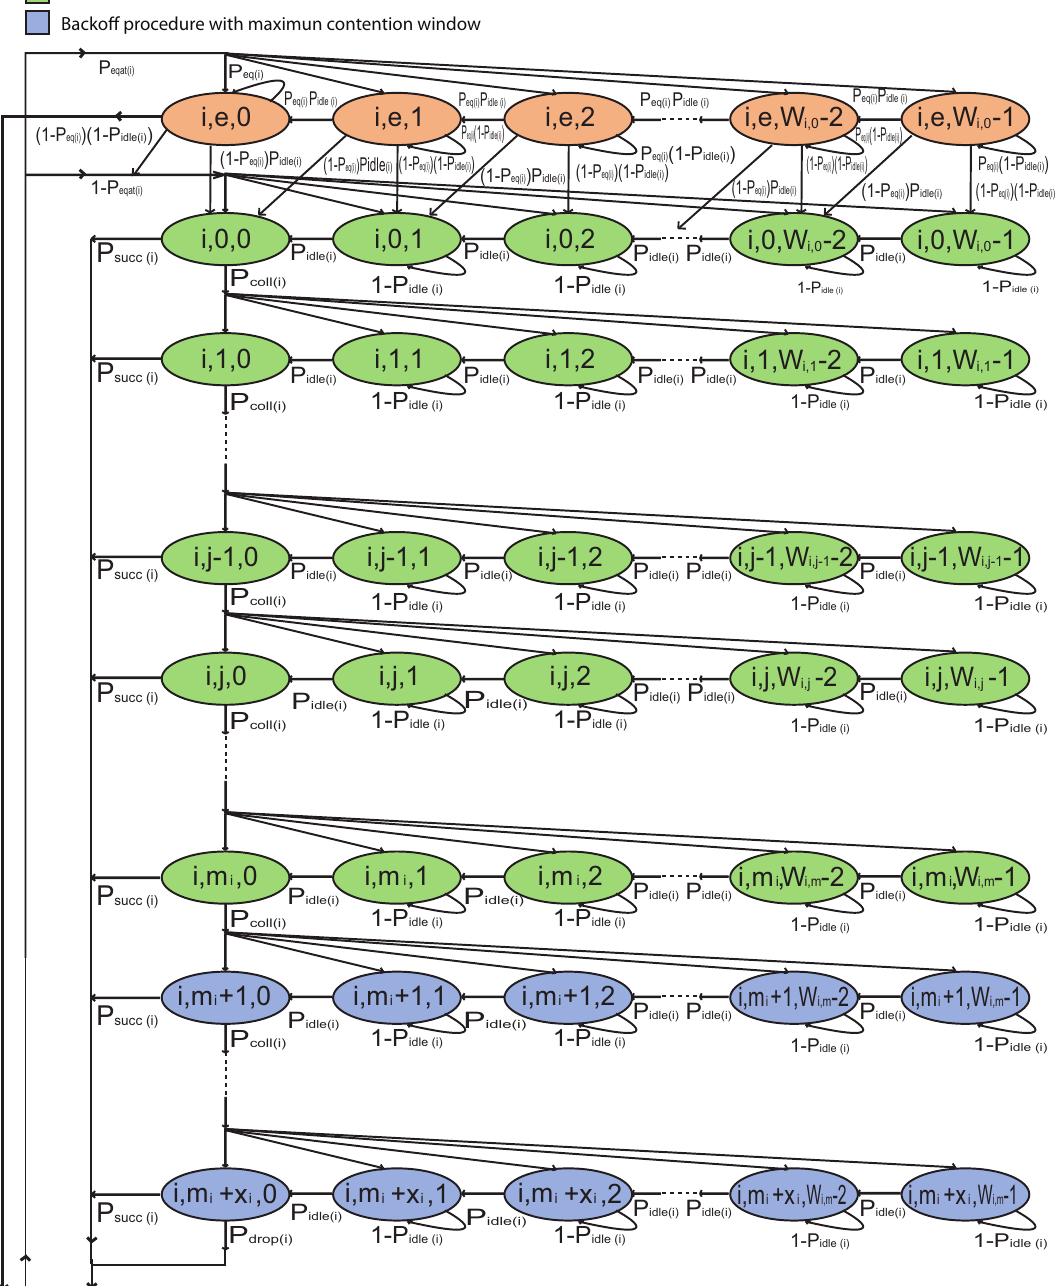
Figure 4. Markov chain model for the backoff procedure of a vehicle with both saturated and non-saturated